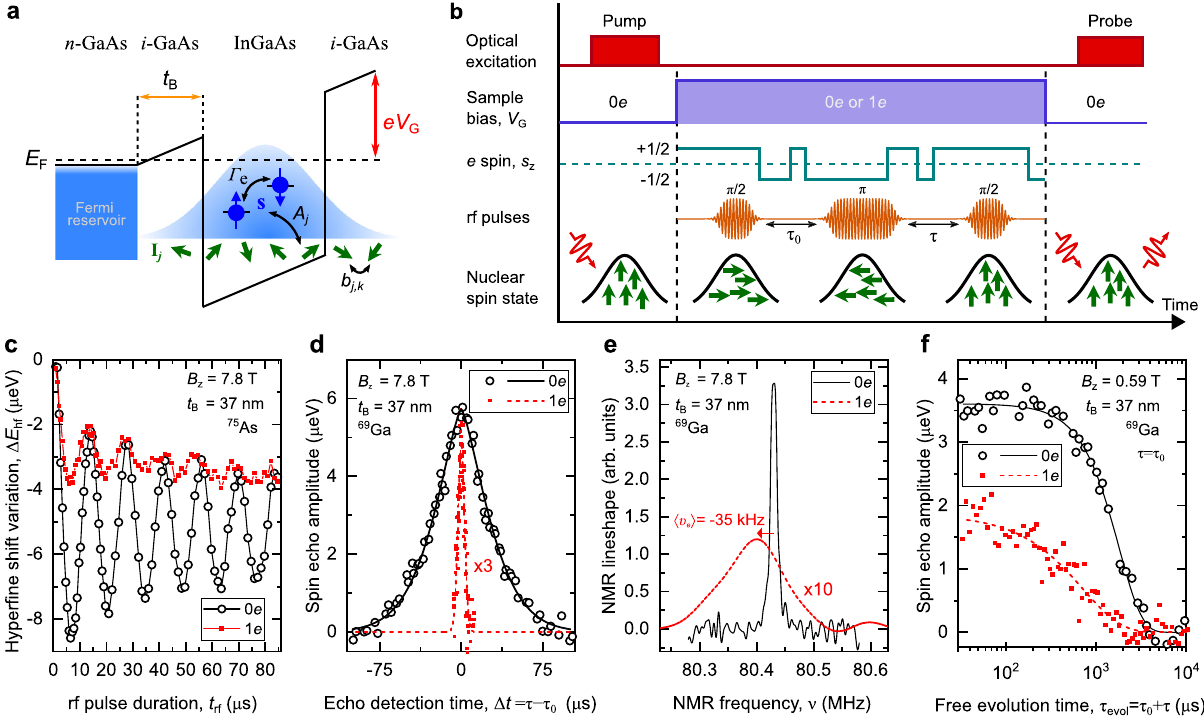
Fig. 1 Coherent control of nuclear spins coupled to quantum dot electron spin qubit. a Schematic of a conduction band edge in an n - i -Schottky diode structure containing InGaAs QDs, separated from the electron Fermi reservoir by a tunnel barrier of thickness t B . Sample gate bias V G is adjusted with respect to Fermi energy E F to achieve single-electron (1 e ) QD charging. The electron spin s (ball and arrow) couples to the nuclear spin ensemble I j (small arrows) via inhomogeneous hyper fi ne interaction. Relaxation between electron spin-up ( ↑ , s z =+ 1/2) and spin-down ( ↓ , s z = − 1/2) states is characterized by rate Γ e . b NMR experiment timing diagram showing optical pump and probe pulses, used to polarize and measure polarization of the nuclear spins, respectively. Radio- frequency (rf) pulses implementing coherent nuclear spin control at an arbitrary V G are sketched for spin echo sequence ( π /2) x − τ 0 − ( π ) x − τ − ( π /2) x . The electron spin s z undergoes random transitions between its two states. c Rabi oscillations of the 69 Ga nuclear spins induced by a resonant rf pulse of variable duration t rf in an empty (0 e , circles) and charged (1 e , squares) QD in the t B = 52nm sample at B z = 7.8 T. Lines are a guide to the eye. d Spin echo evolution as a function of the second delay τ in the t B = 37nm sample at B z = 7.8 T, revealing free induction decay in 0 e (circles, τ 0 = 150 μ s) and 1 e states (squares, τ 0 = 7.5 μ s, data multiplied by 3). Lines show compressed exponential fi ts used to derive the nuclear spin dephasing times T (cid:4) . e Fourier transform of ( d ) showing spectral 2 ; N broadening and the average Knight shift 〈 ν e 〉 ≈ − 35kHz induced by equilibrium electron spin polarization. Data for 1 e is multiplied by 10. f Spin echo decay measured by varying the total free evolution times τ evol = τ 0 + τ at τ 0 = τ . Lines show fi tting used to derive the nuclear spin coherence times T 2,N